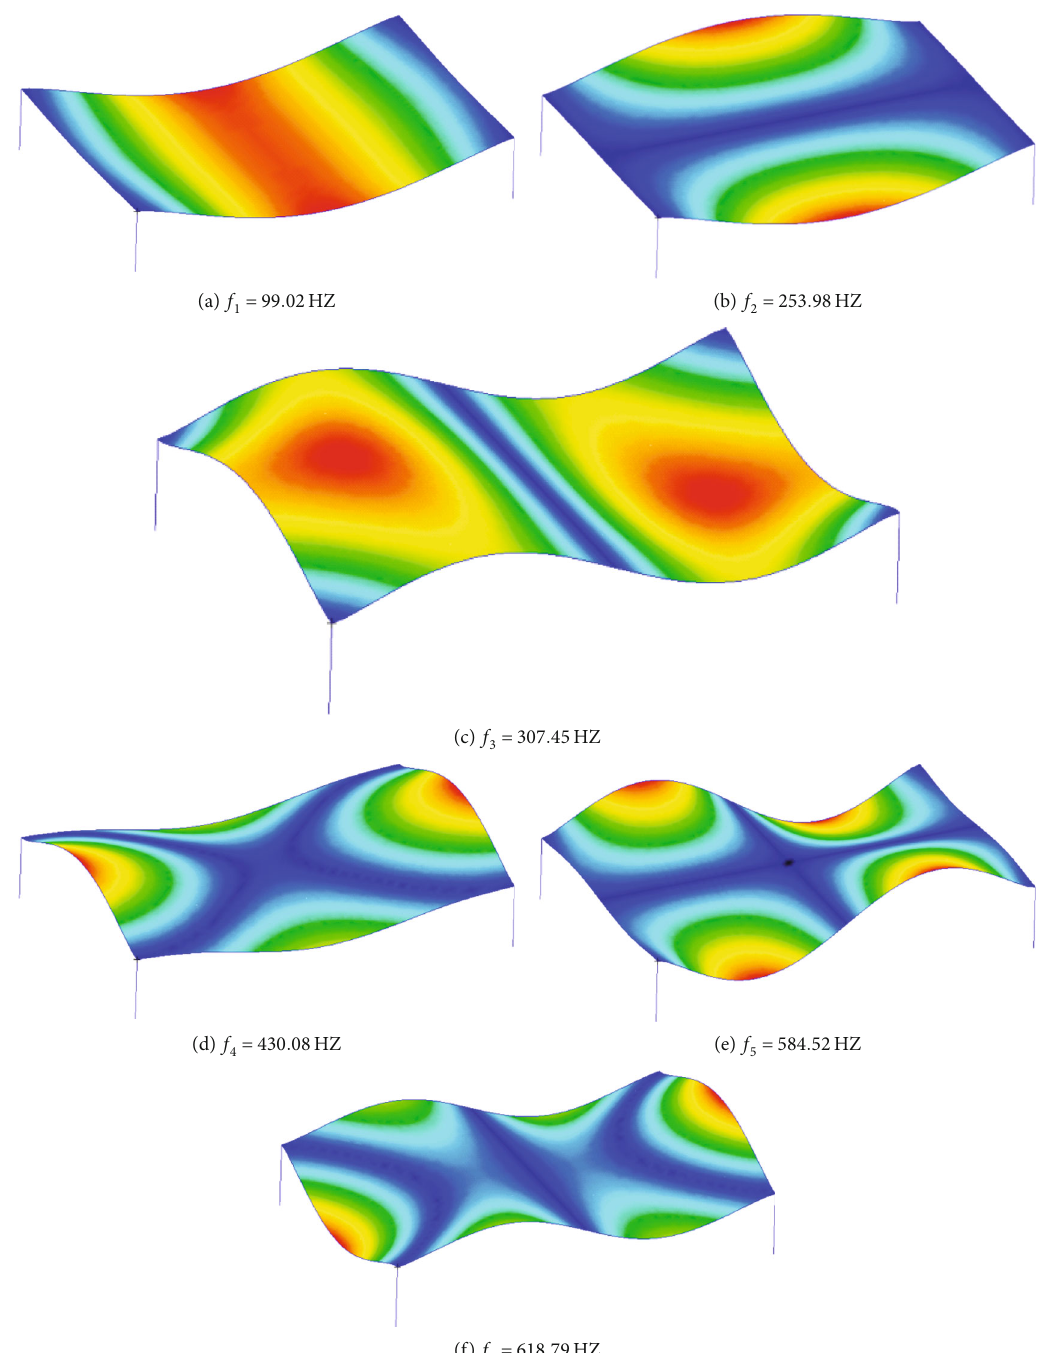
Figure 17: Frequencies and mode shapes of fi rst six modes for optimal